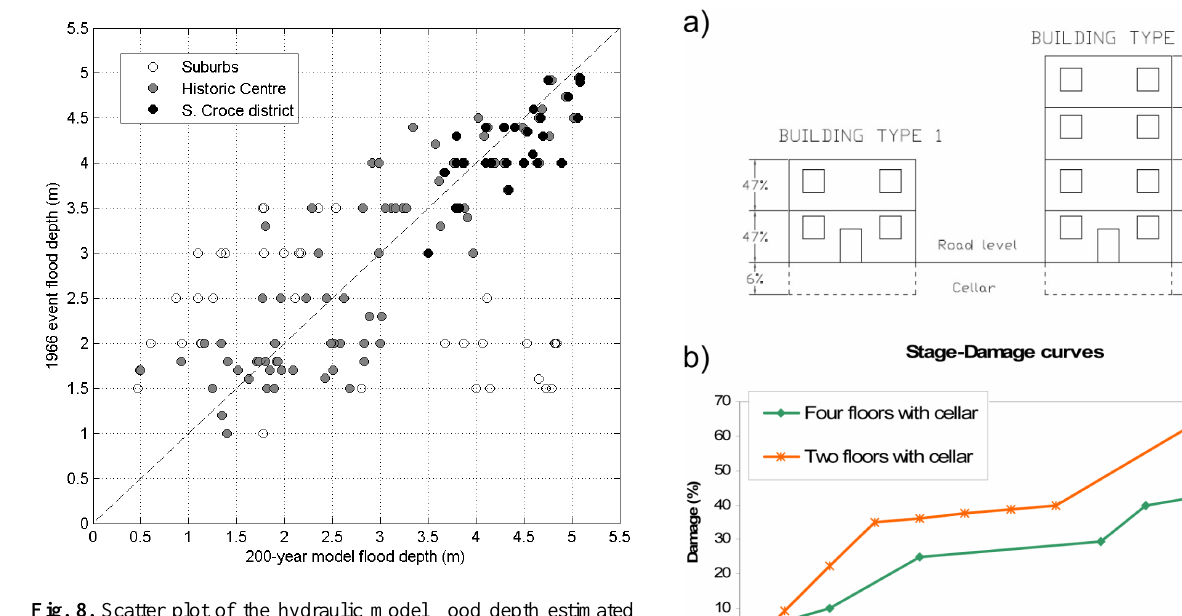
Fig. 8. Scatter plot of the hydraulic model flood depth estimated for the 200yr event vs maximum water depth from the 1966 event historical plates. Different symbols are used for different study areas as in Fig. 5.